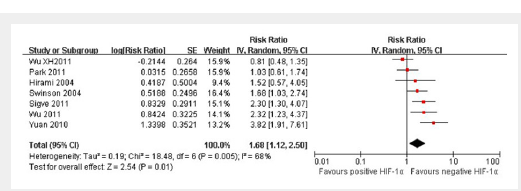
Figure 5 Forest plot of association between HIF-1α expression and overall